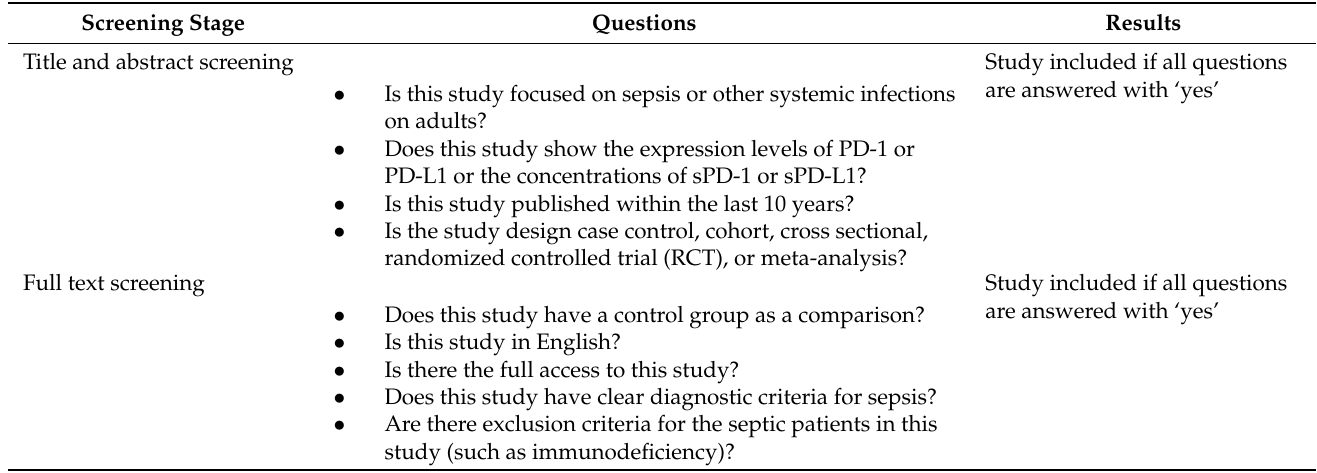
Table 1. List of questions used for inclusion and exclusion of studies over the title and abstract, as well as the full